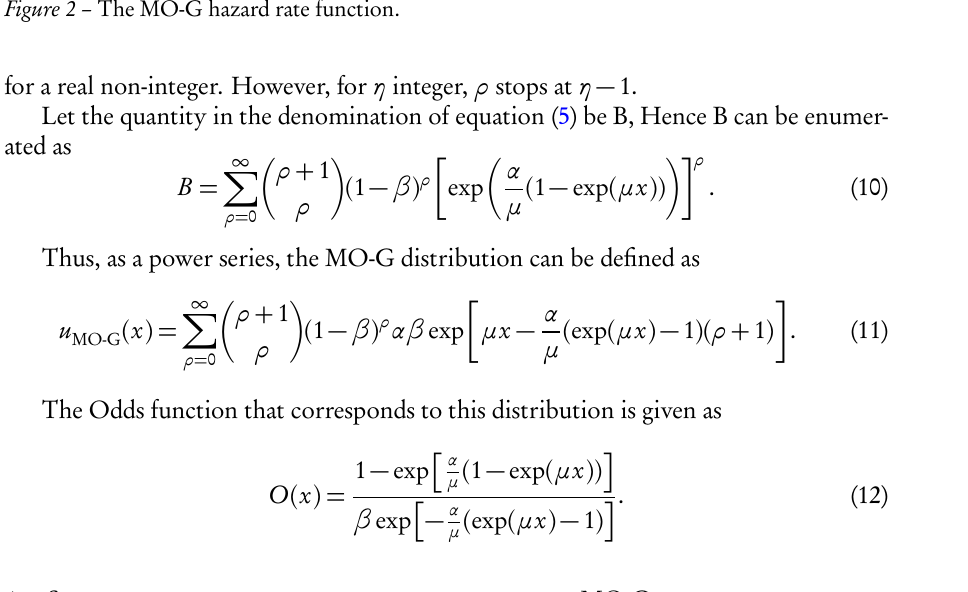
Figure 2 – The MO-G hazard rate